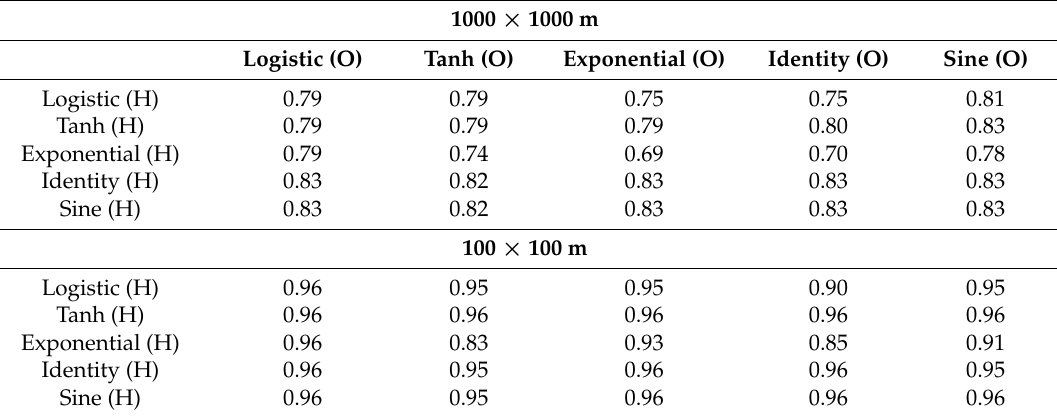
Table 3. Average quality of the validation sample of the network depending on the activation function used (H: Function for hidden, O: Output